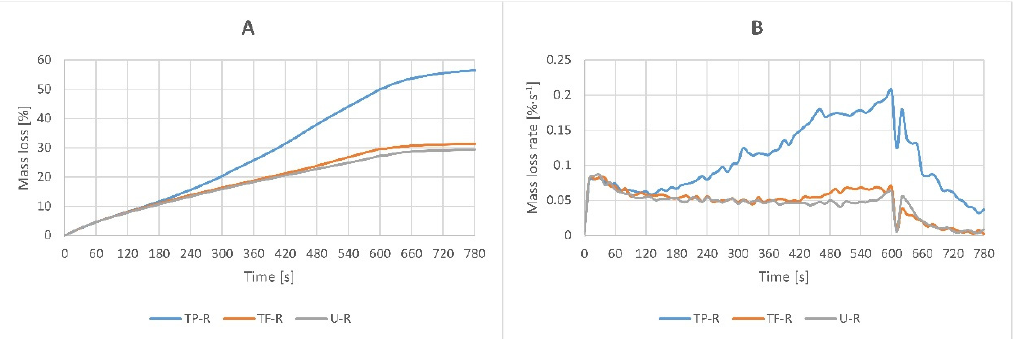
Figure 6. Mass loss and relative mass loss rate over time for TP − R, TF − R, and U − R specimens. ( A ) Mass loss; ( B ) mass loss rate. Table 4. ANOVA of mass loss of TP − R, U − R specimens at 780 s. Df Sum Sq Mean Sq F Value Pr (>F) Specimens